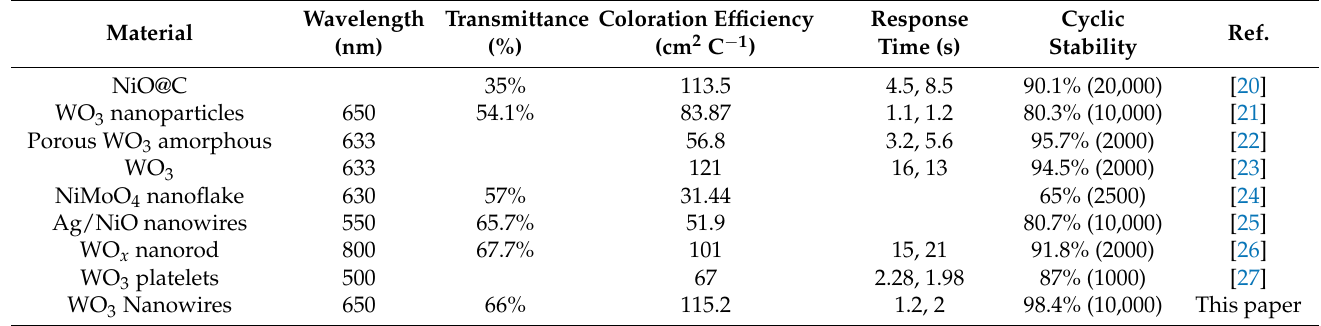
Table 1. Comparison of Electrochromic Properties.